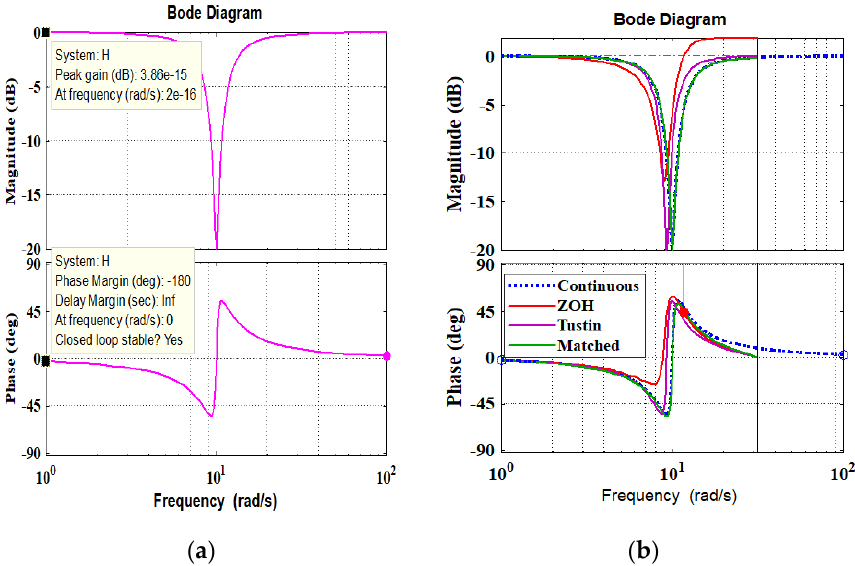
Figure A1. ( a ) Bode plot result of the notch filter. ( b ) Discretized comparative bode plot results.